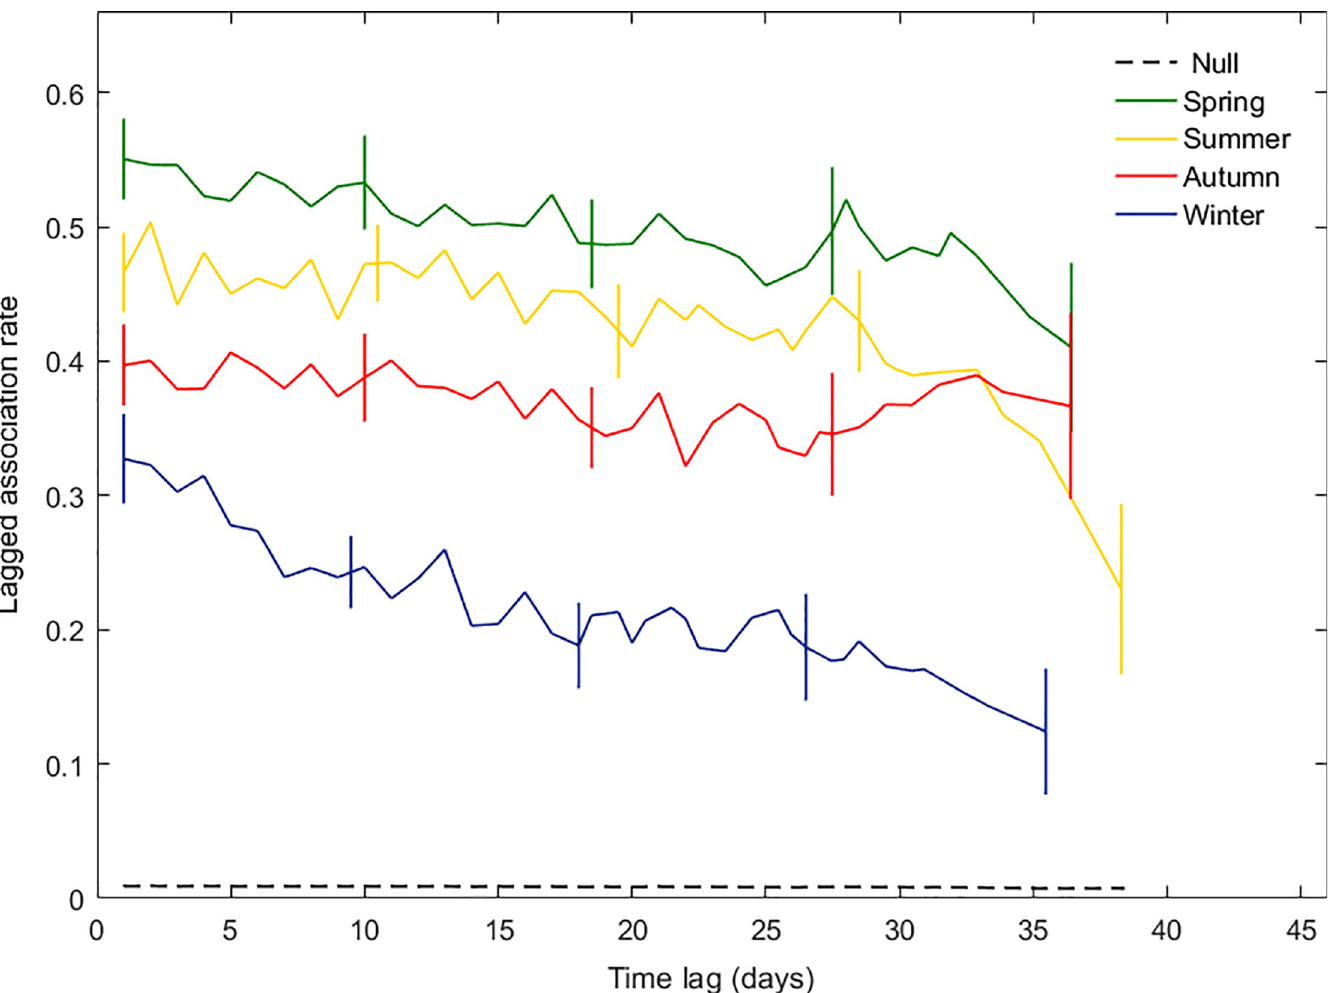
Fig 6. The probability that pairs of foxes that associated on a given day would re-associate at a later time (lagged association rate, LAR) within seasons (maximum lag = 40 days) and the expected association rate if associations were random (null association rate, NAR) calculated across all data. Vertical lines show jack-knife standard